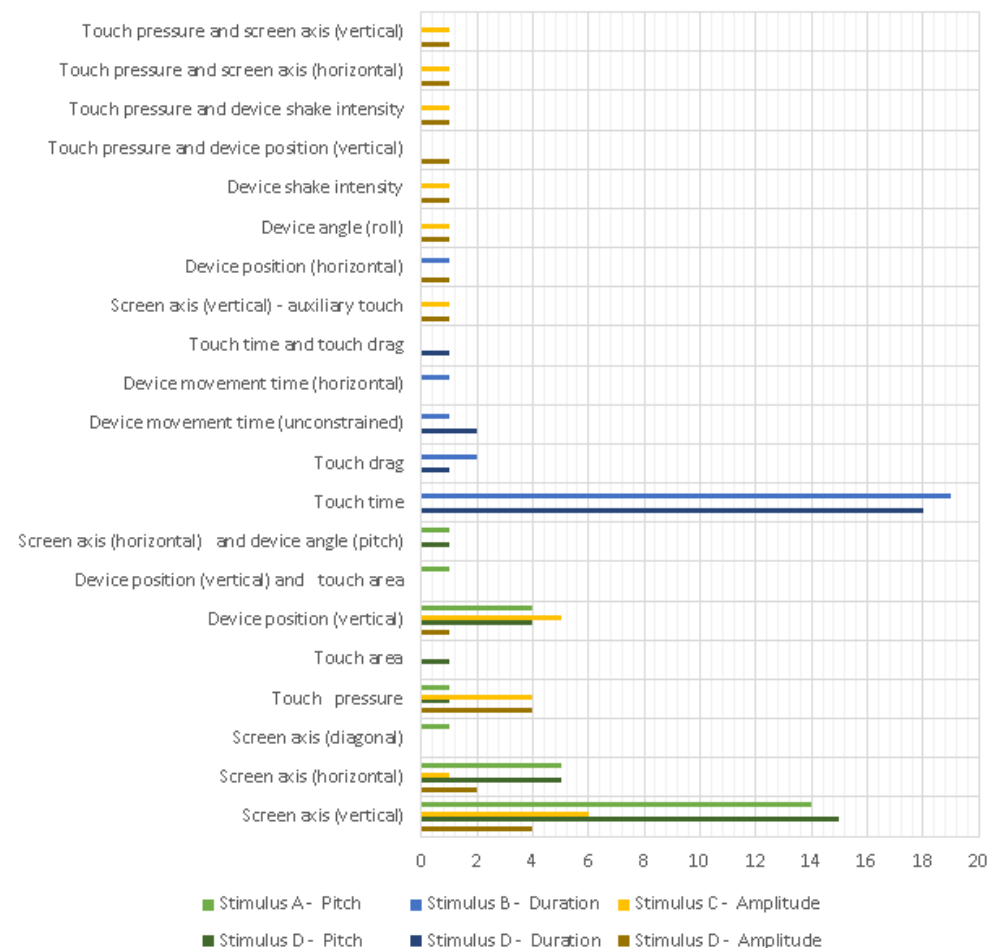
Figure 11. Frequency of participant (musician and non-musician) gesture choice in phase 2—uncategorized gestures. Full results reference: Tables A10–A15.